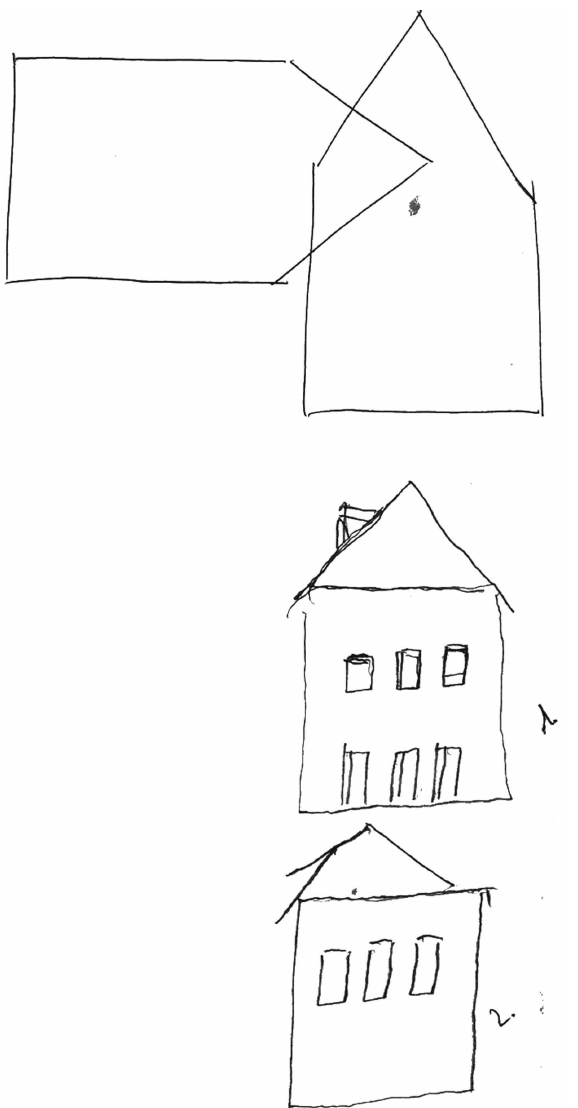
Figure 1: Intersecting pentagons drawing from the Mini-Mental State Examination reflects patient’s